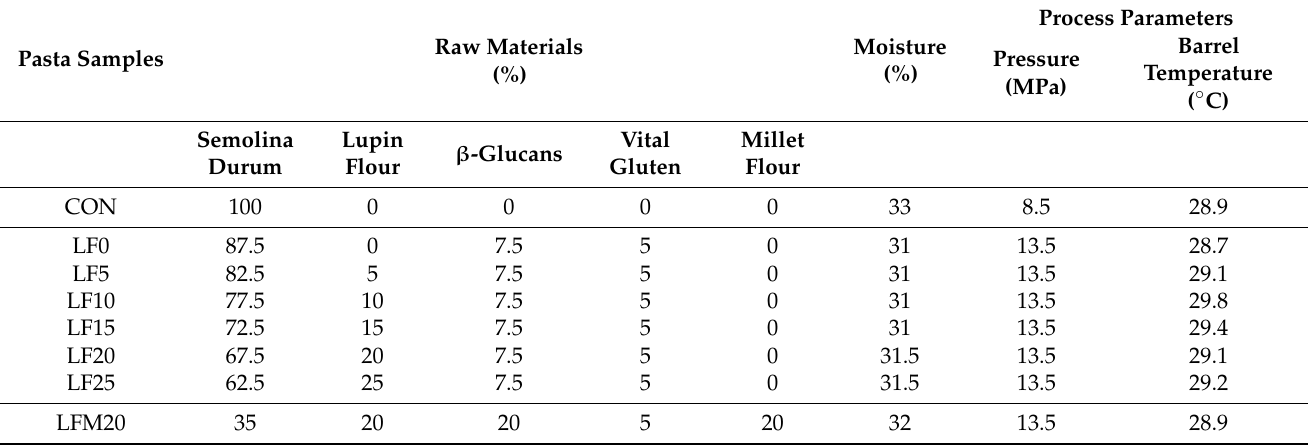
Table 1. Model of the